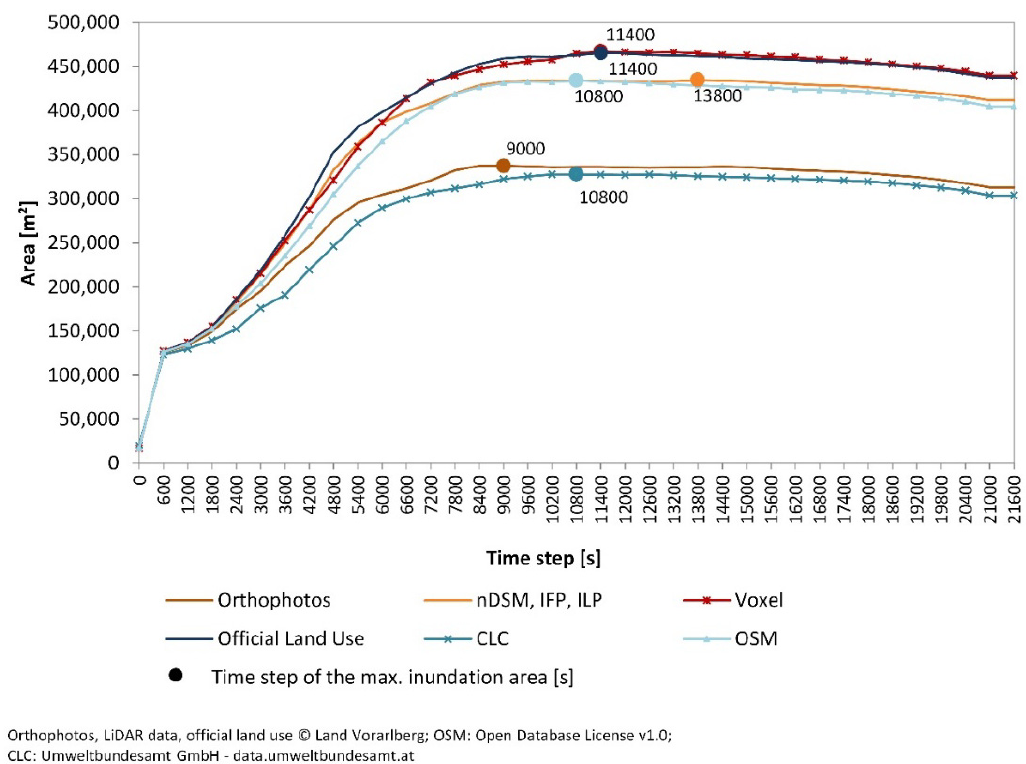
Figure 4. Development of the inundation area with time steps